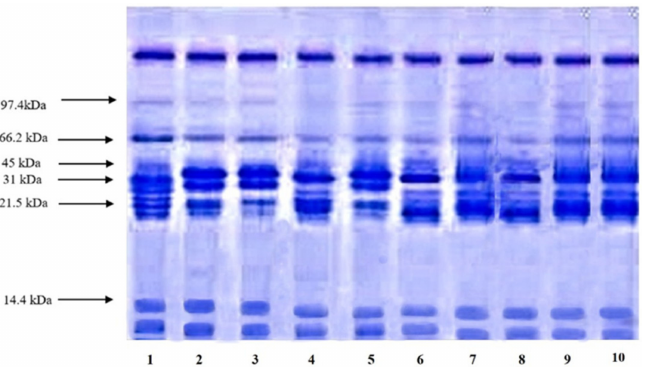
Figure 5. SDS-PAGE of absorbed API of 1% w / v emulsion. Lane 1 marker, lane 2 to lane 4 correspond to the interfacial composition of API in distilled water at pH 3, 7 and 9. Lane 5 to 7 present the interfacial composition of API in the presence of NaCl at pH 3, 7 and 9. Lane 8 to lane 10, interfacial composition of API in the presence of CaCl 2 at pH 3, 7 and